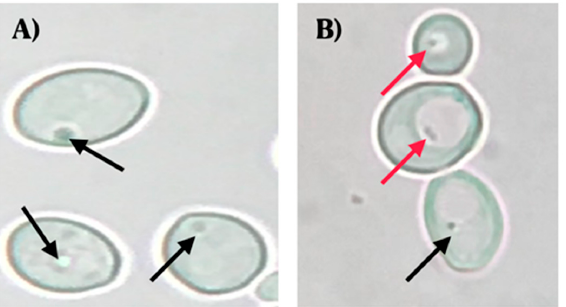
Figure 1. Wet mounts (objective lens magnification 100×) of yeast cells obtained from colonies cultured on chloramphenicol-supplemented Sabouraud Dextrose Agar. ( A ) C. albicans ATCC 90028 strain (negative control) (objective lens magnification 100×). ( B ) C. albicans isolated from a vaginal discharge sample of a term pregnant woman showing the presence of bacteria-like bodies (BLBs) within vacuoles of yeast. Red arrows indicate BLBs, while black arrows indicate nuclei of yeast cells. Micrograph B is a representative image of one of the triplicates of one of the vaginal discharge samples positive for the presence of intra-yeast bacteria-like bodies.